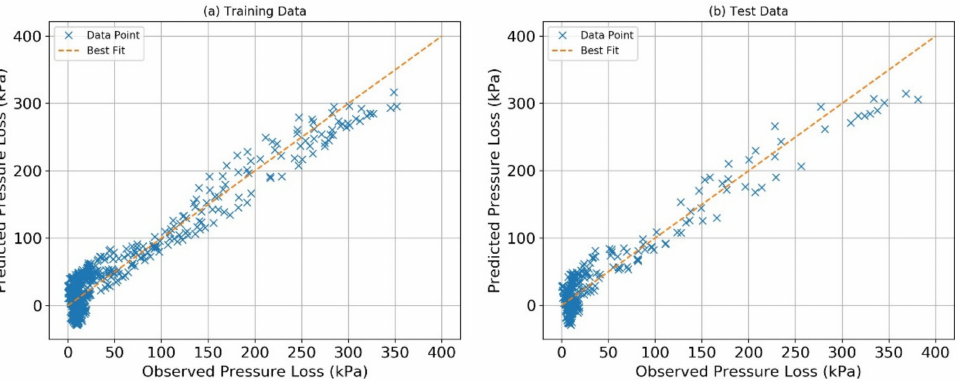
Figure 1. Support Vector Machine (SVM) predicted pressure plotted with observed pressure loss: ( a ) training dataset and ( b ) test